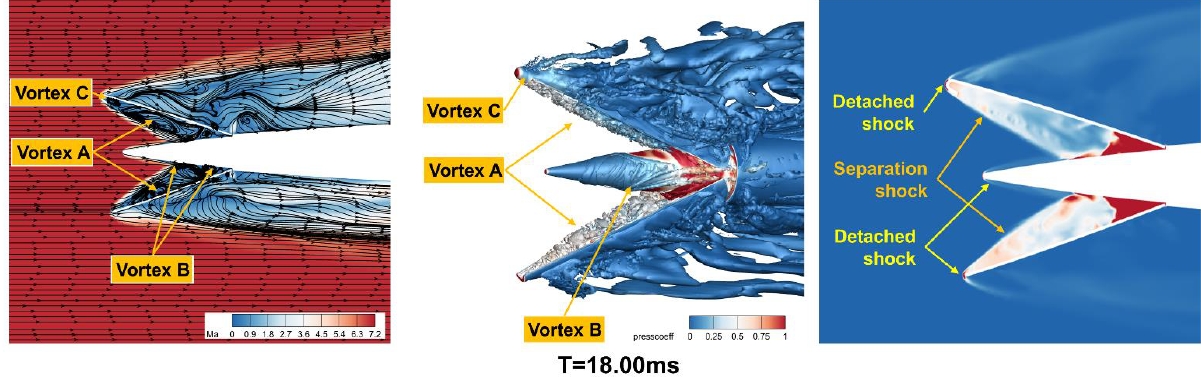
Figure 21. The contour of the streamline and Mach number ( left ), iso-surface of Q-criterion ( middle ), and the contour of the pressure coefficient ( right ) at T = 18.00 ms.